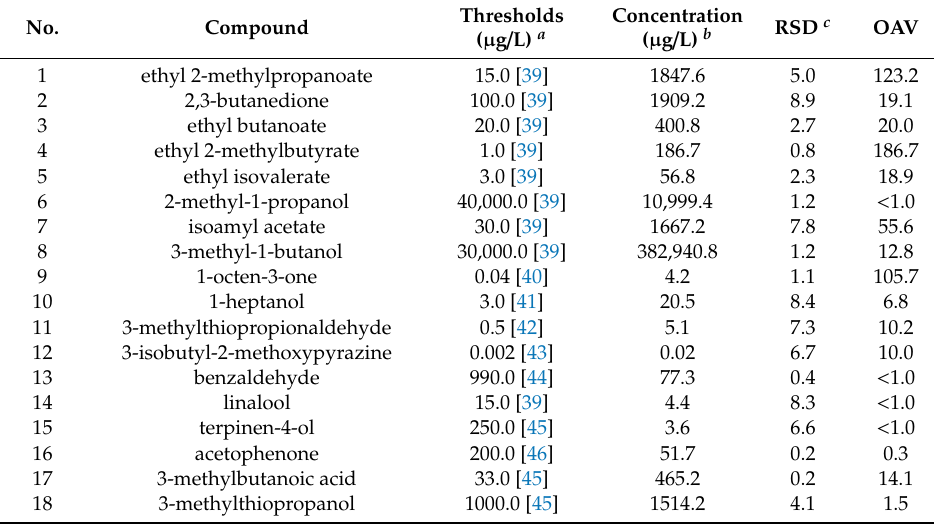
Table 2. Quantitative data odor thresholds and odor activity values (OAVs) of aroma compounds in Marselan